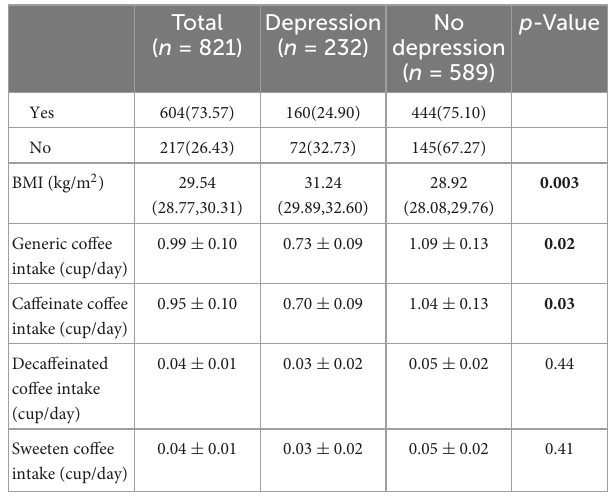
TABLE 1 Basic characteristics of the